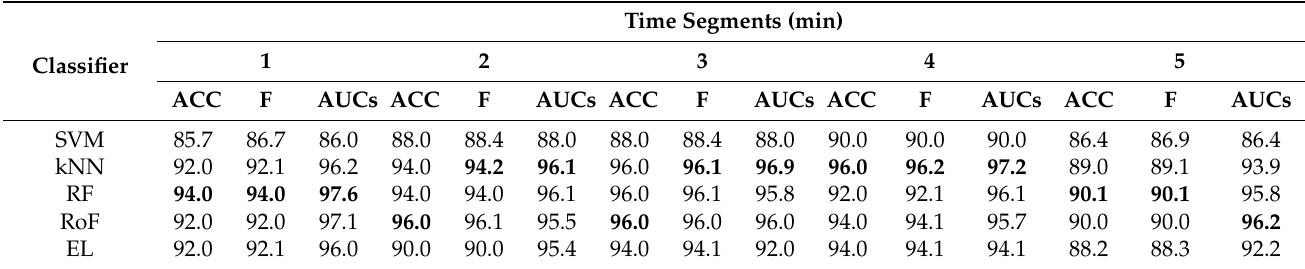
Table 6. The average F (%) and AUCs (%) obtained by the DSA method for a varied length of the time segments in the AFPDB database. Bold values indicate the best performance in a column.